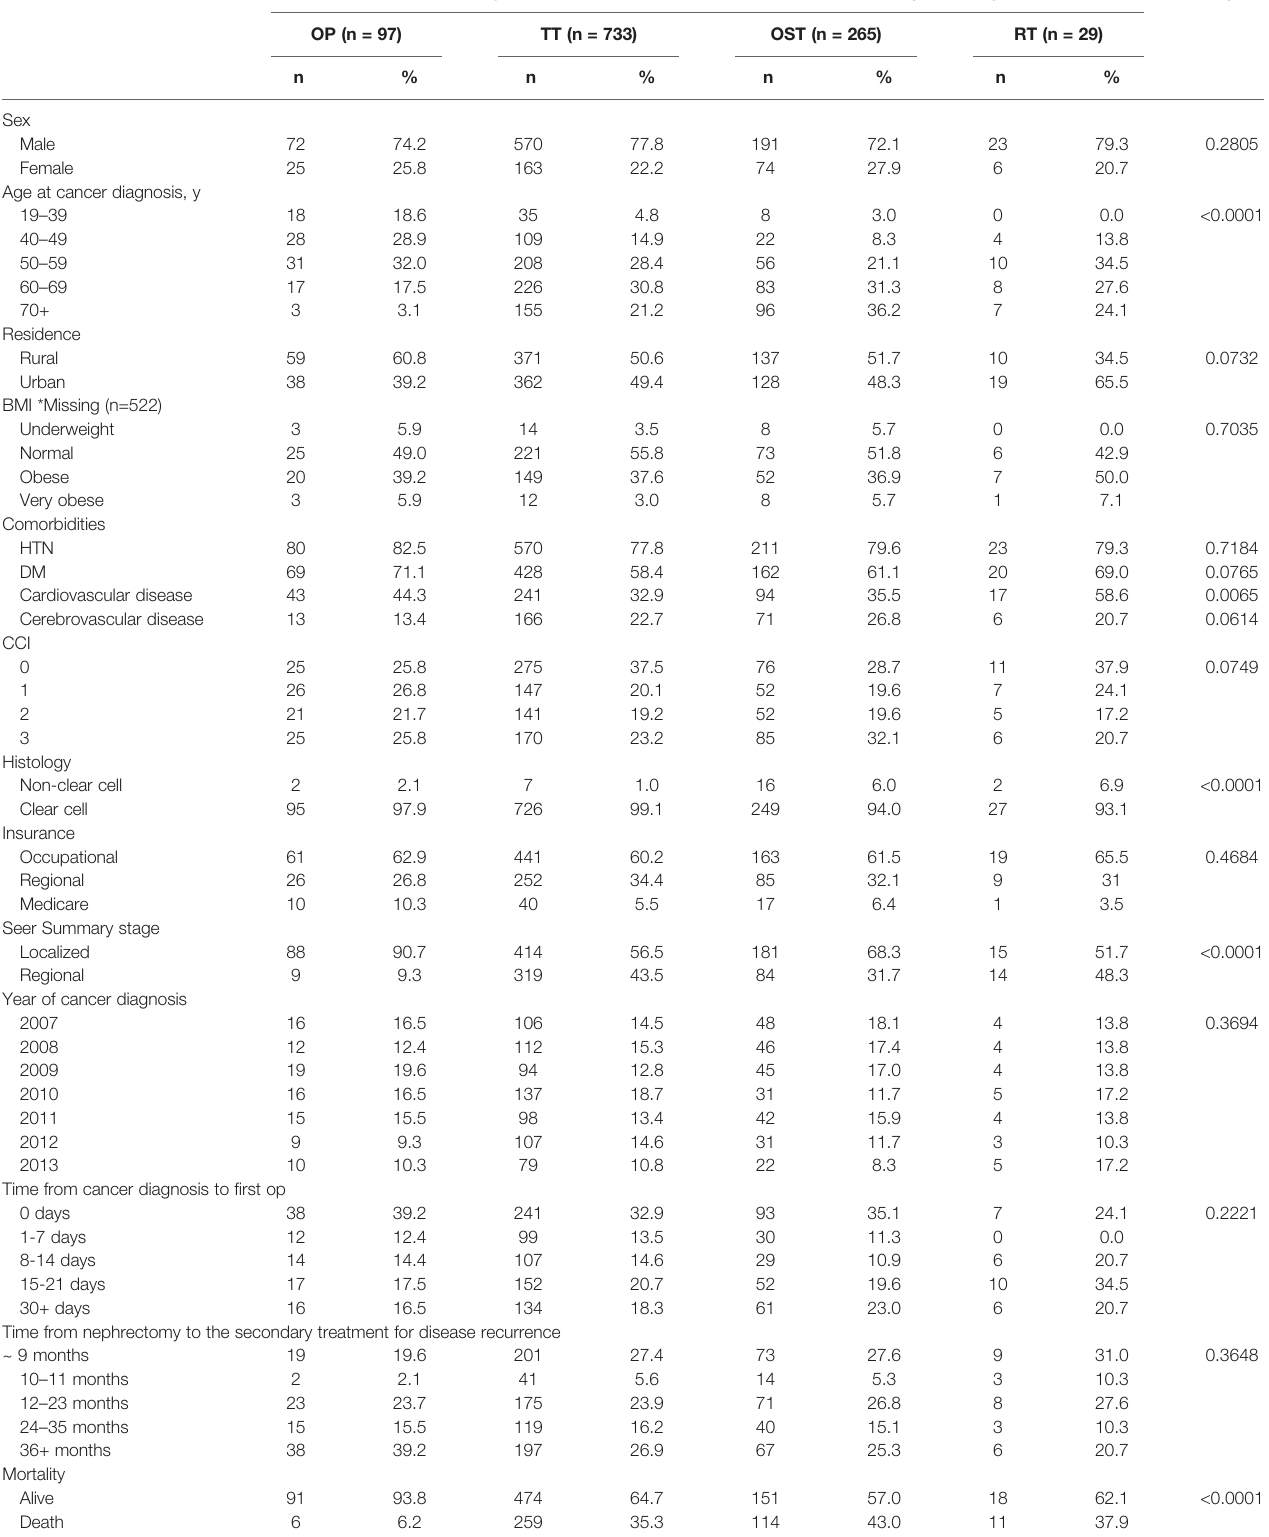
TABLE 2 | Baseline characteristics among 1124 radically nephrectomized patients. Secondary treatment for disease recurrence after radical